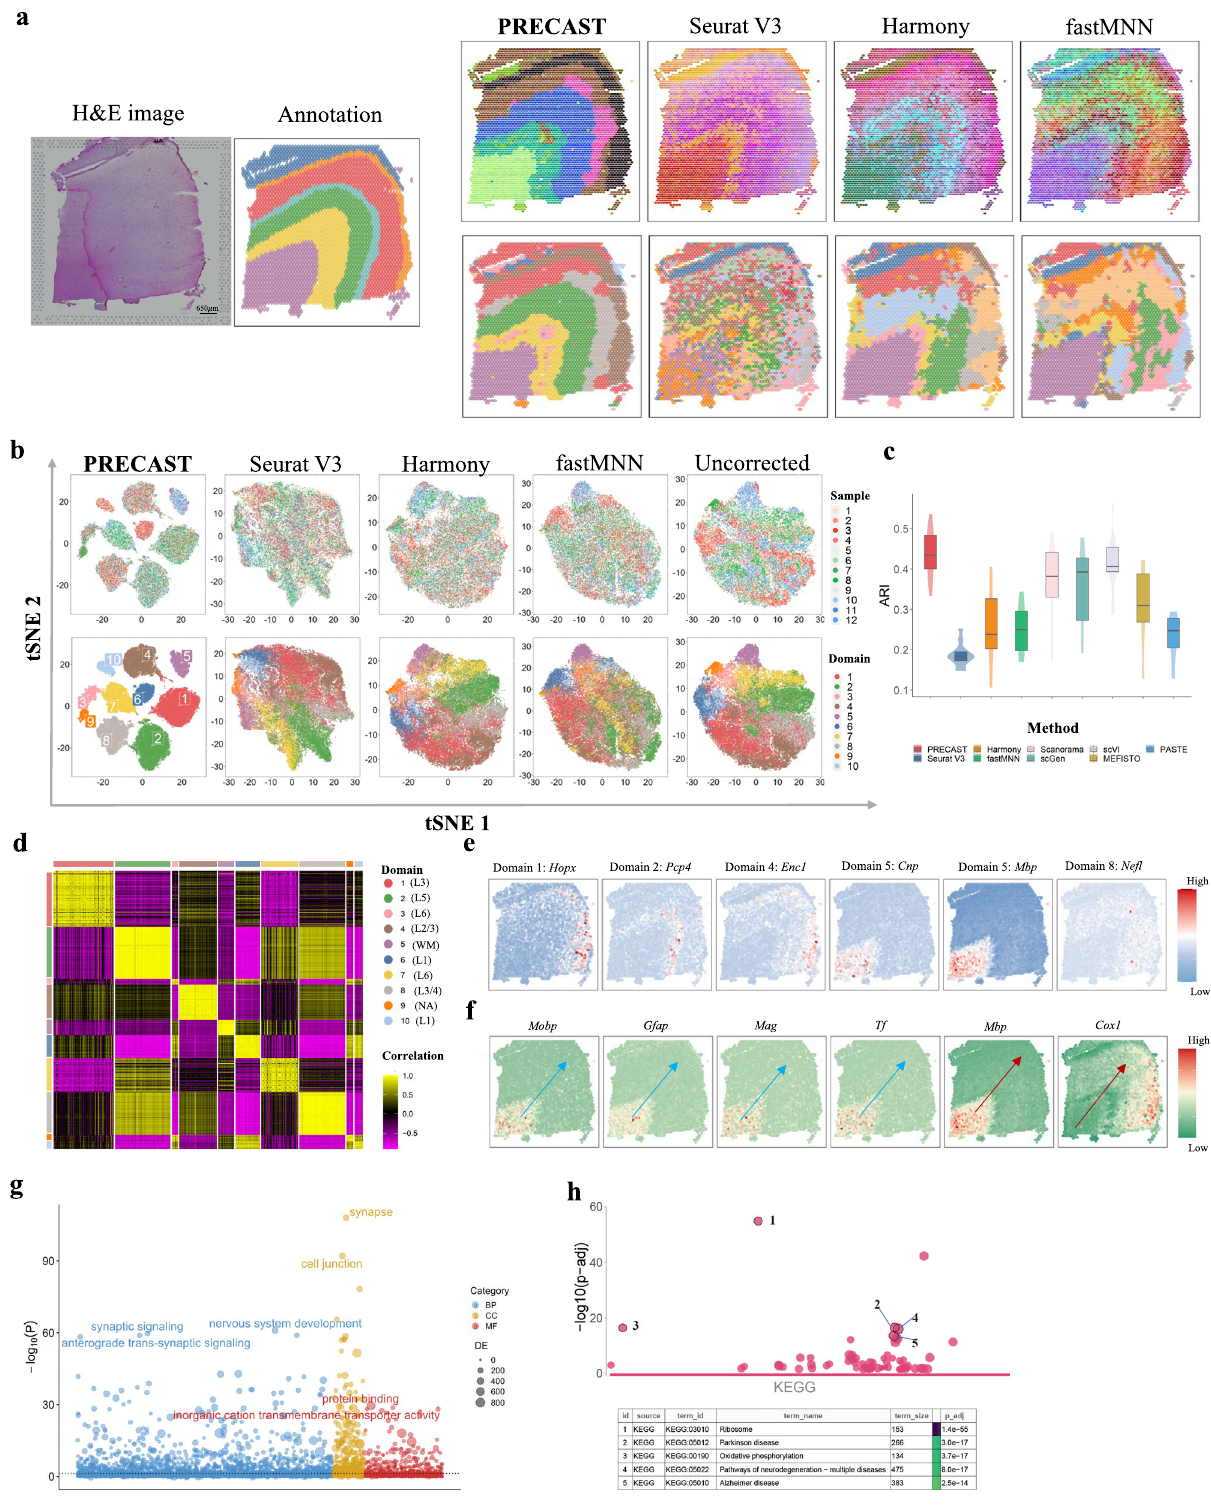
(Fig. 2b, top panel) while the domain clusters were well segregated (Fig. 2b, bottom panel), and there were signi fi cant improvements in visualization in comparison to the other methods, including the method applied with no corrections. Supplementary Fig. S7c shows that PRECAST achieved the best data integration in terms of F1 scores, iLISI, and cLISI. To evaluate the clustering accuracy, we used both ARI and NMI. As shown in Fig. 2c and Supplementary Fig. S7d, PRECAST achieved the highest ARI and NMI for the separate evaluation and